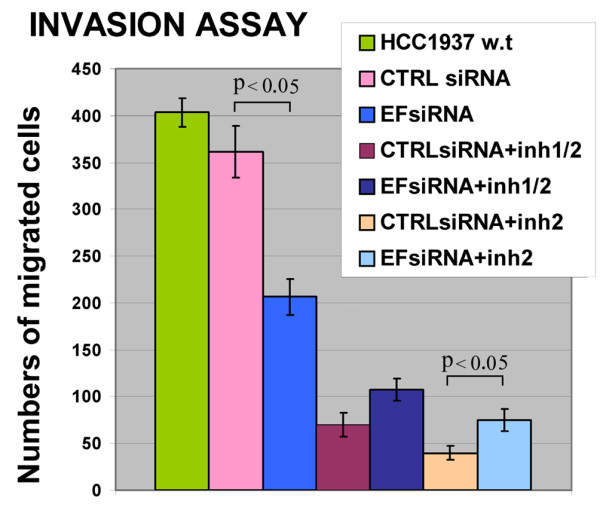
Invasion of HC1937 cells measured by matrigel assays. Numbers of migrated cells were counted and each data point represents the mean of three independent experiments.